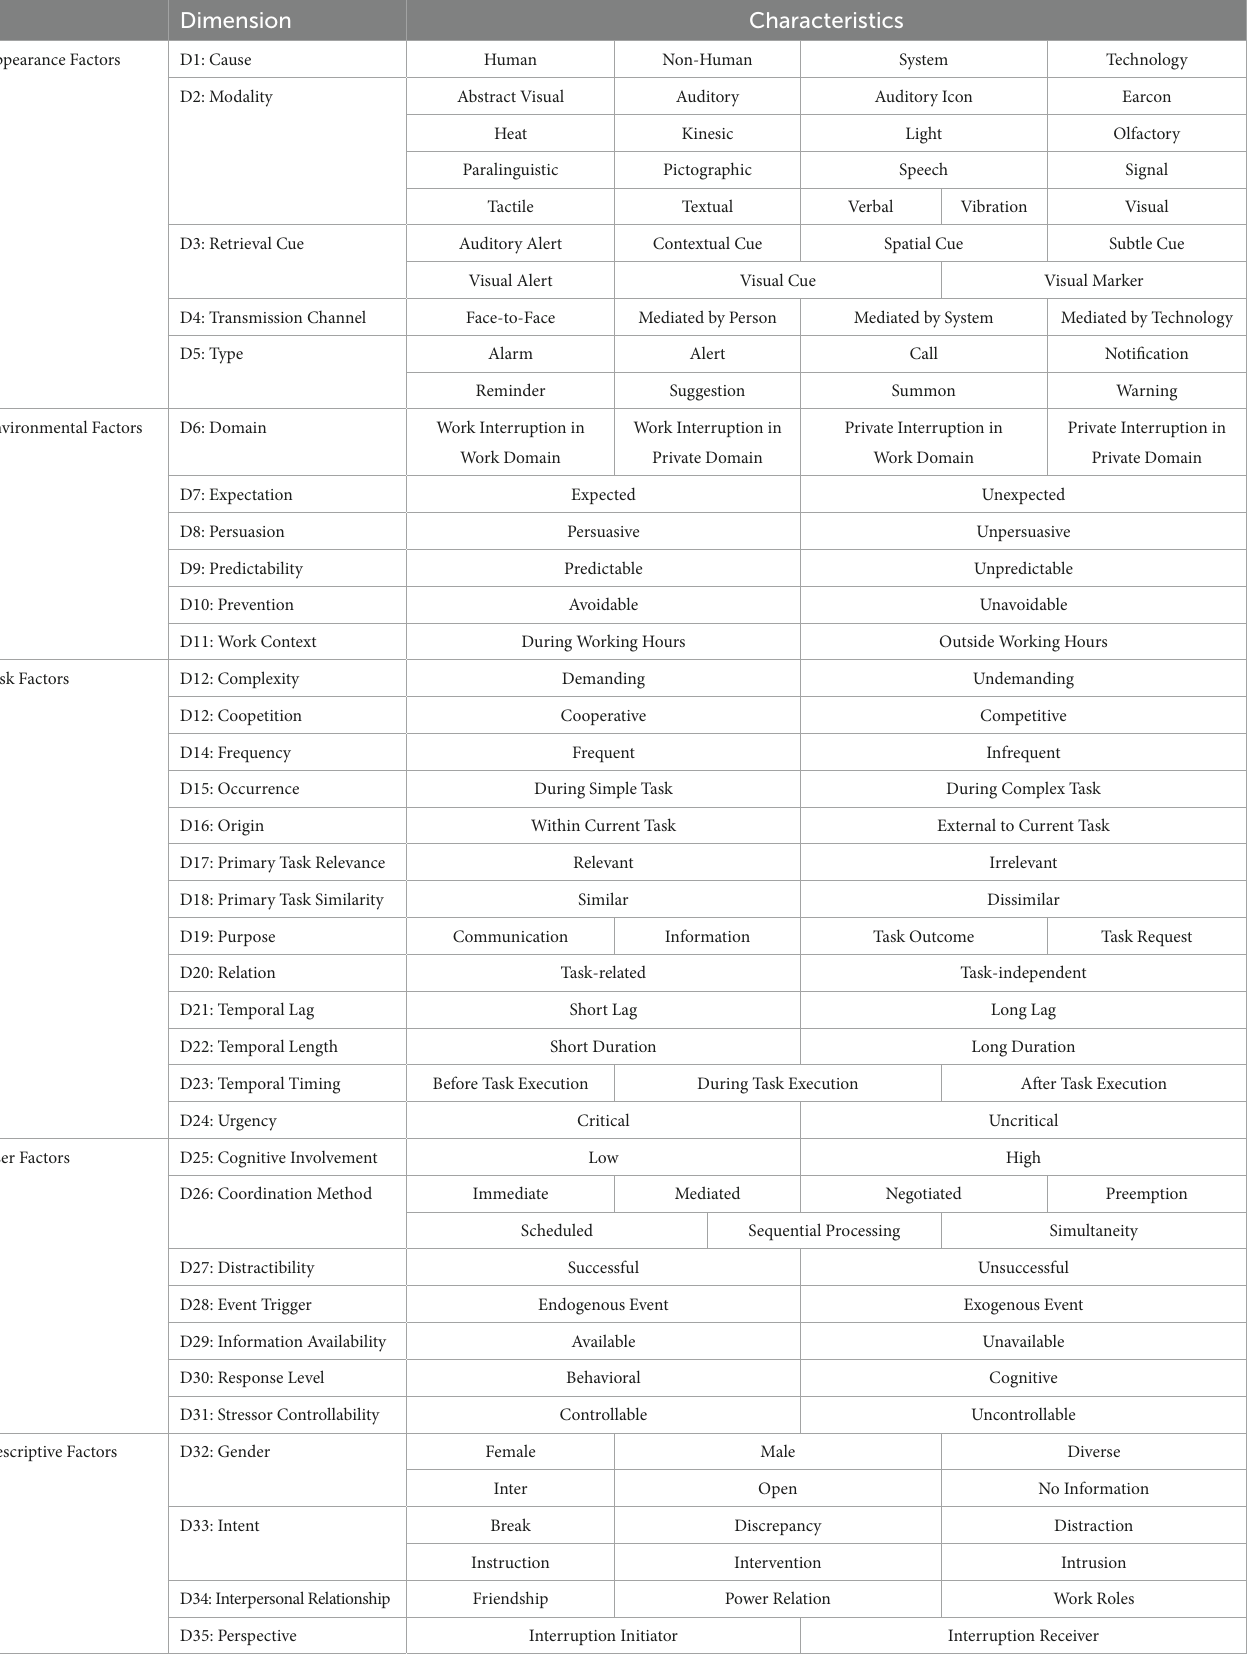
TABLE 5 Taxonomy of